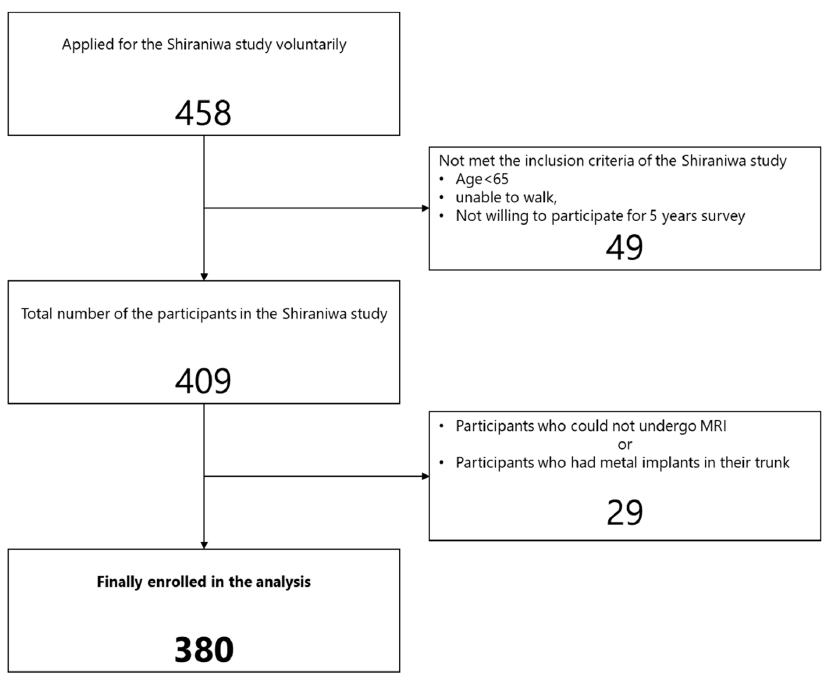
Figure 1. Flowchart of the included and excluded participants. A total of 380 participants were enrolled for this analysis.